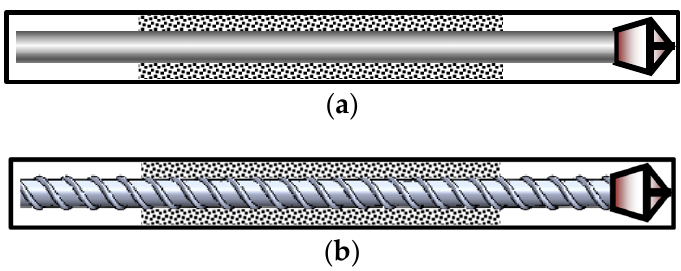
Figure 5. Borehole clogging in different drill pipes. ( a ) a round drill pipe; ( b ) a spiral drill pipe. (4)